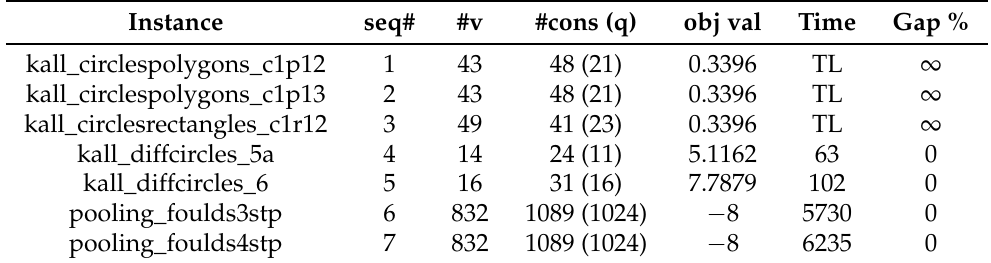
Table 6. Statistics of different test instances, and the solving results by SCIP.